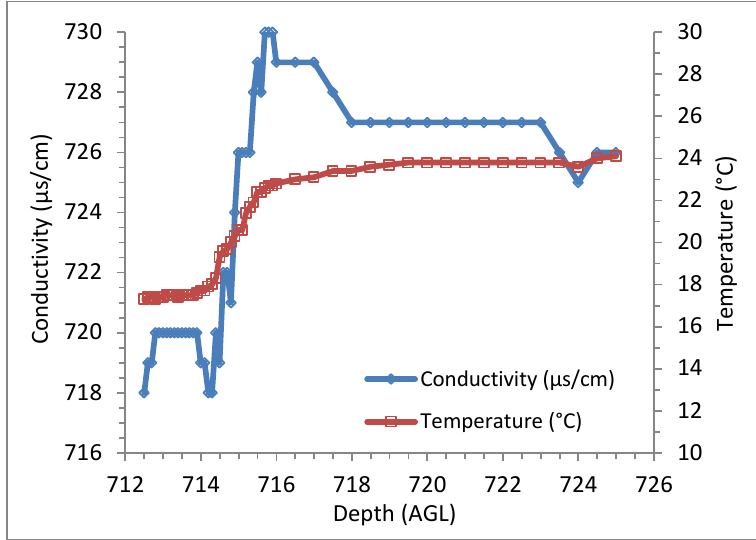
Figure 17. Fluctuation in temperature and conductivity at profile n°1